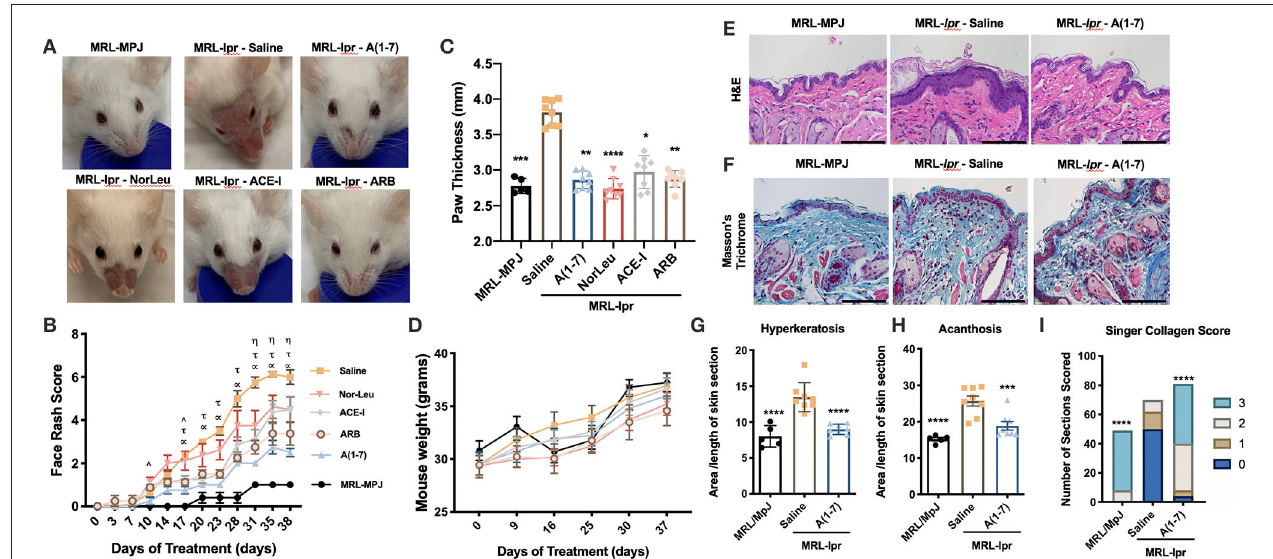
FIGURE 1 | Pathologies associated with SLE are ameliorated with RAS modulation. MRL -lpr mice were treated with either saline, A(1-7), NorLeu, ACE-I or ARB; MRL-MpJ mice were used as healthy controls. (A,B) Skin lesions were scored every 3–5 days according to the following criteria: 0, not noticeable rash; 1, little redness, no hair loss, or inflammation; 2, minimal rash, little hair loss, or inflammation; 3, moderate rash, increased hair loss, light inflammation; 4, pronounced rash, near total hair loss, and obvious inflammation; 5, Rash is traveling up the face; 6, obvious wound above nose. Statistical significance is expressed by group A(1-7) ( α ), NorLeu ( η ), ACE-I ( ∧ ), and ARB ( τ ). (C) Paw thickness was measured at the end of the study using a caliper. (D) Mice were weighed weekly throughout the study. (E,F) Tissue taken from the snout was stained using H&E and Masson’s Trichrome, bars represent 110 µ m. (G) Hyperkeratosis was measured by dividing the area